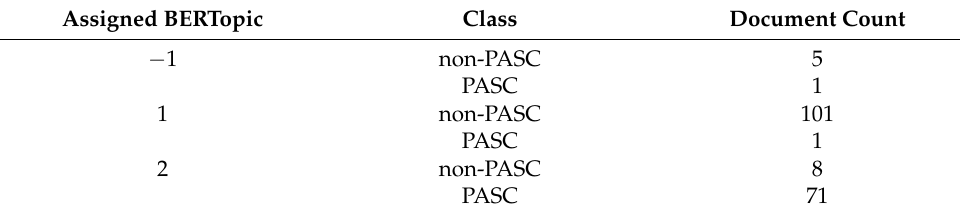
Table 3. Distribution of BERTopic topics wrt the considered classes. Assigned